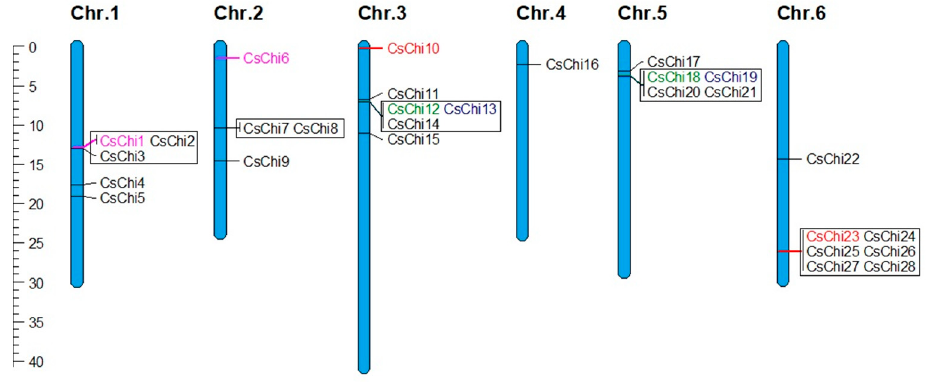
Figure 3. Chromosomal location and duplication of chitinase genes in cucumber. The chromosome size is indicated by its relative length using the information from the cucumber 9930 draft genome ver. 2.0 [19]. Black boxes indicated tandem duplication genes. The paralogous genes were written with same colors. Locations are mapped according to base pair start positions. The chromosome number is indicated above each bar and the scale bar on the left is in megabase (Mb).